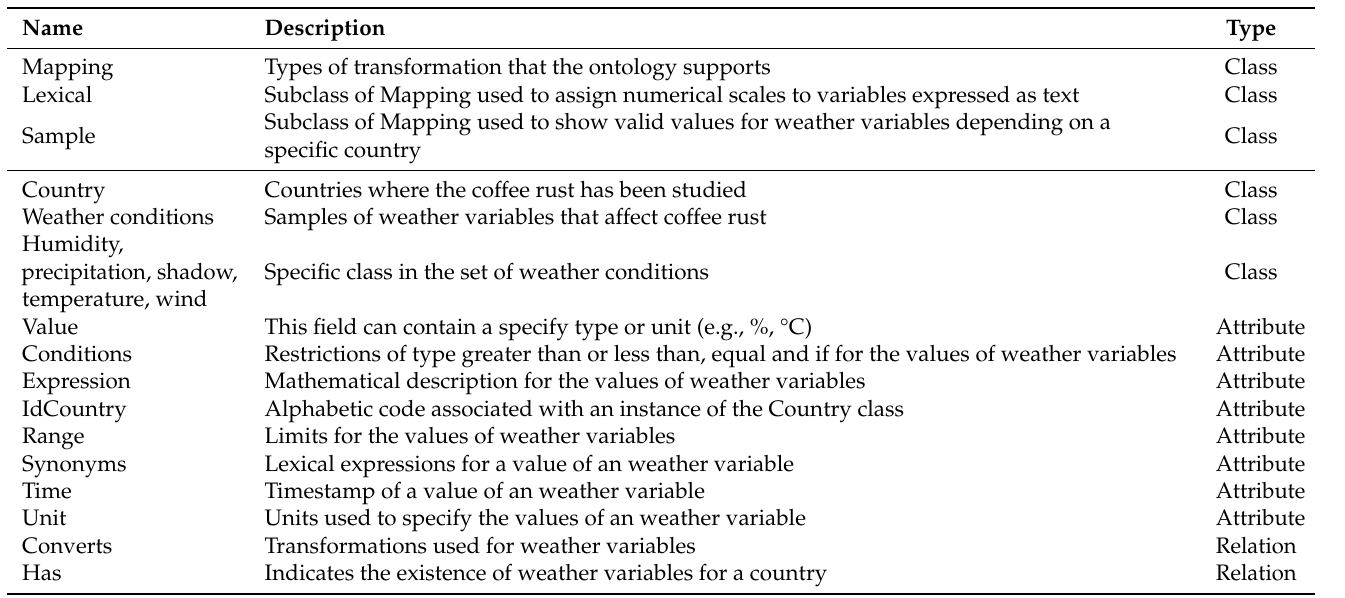
Table 3. Description and type (class, relation, or attribute) of the RustOnt